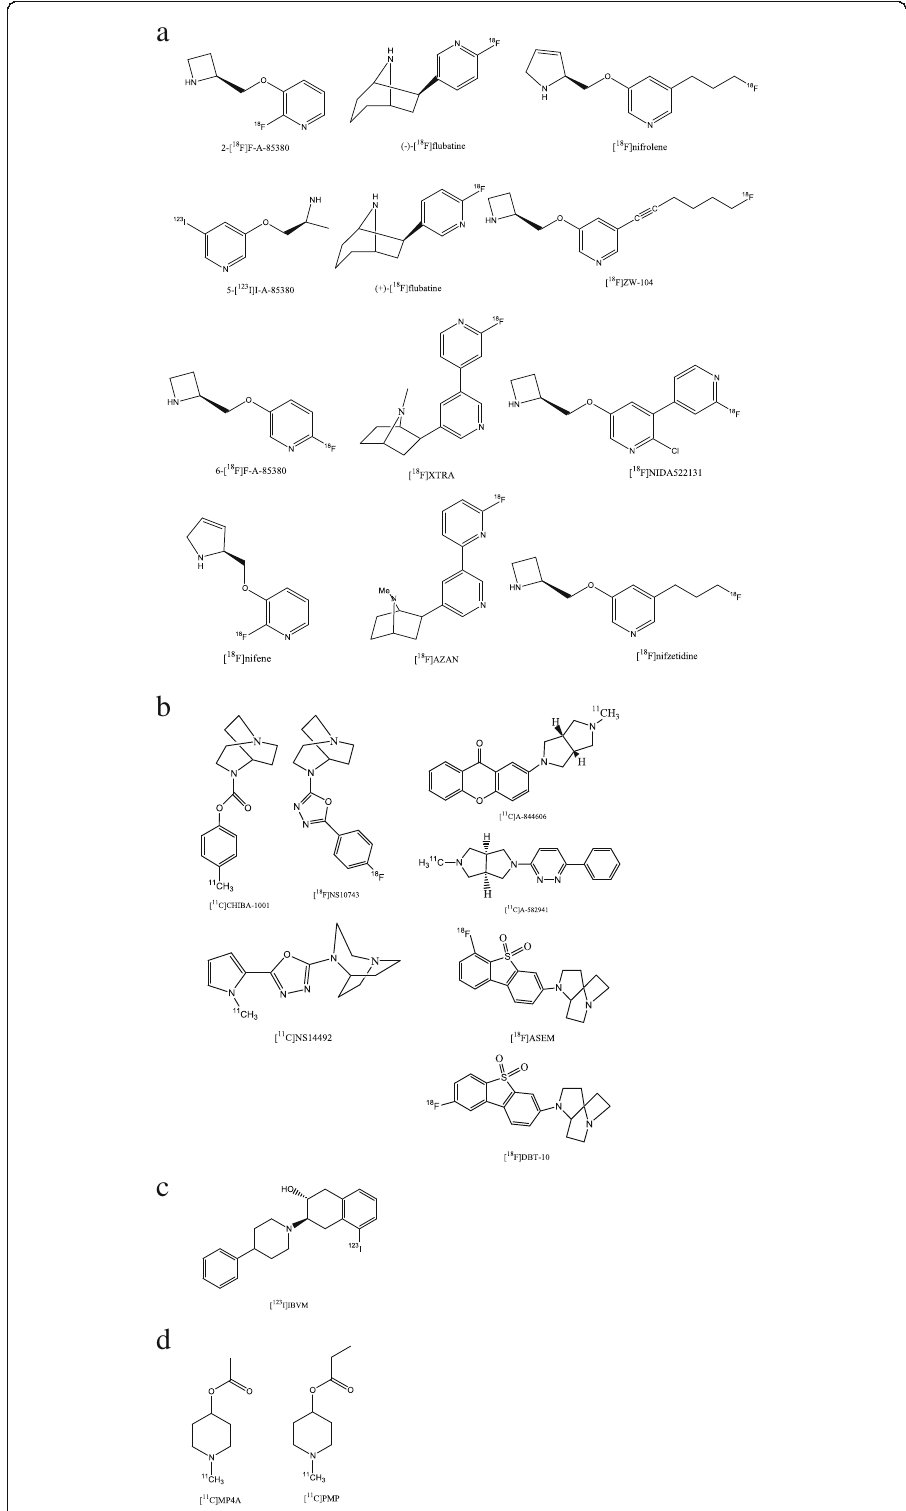
Fig. 5 Chemical structures of radiotracers for imaging the cholinergic system – targeting: a α 4 β 2 nicotinic acetylcholine receptors (nAChRs), b α 7 nAChRs, c vesicular acetylcholine transporter and d